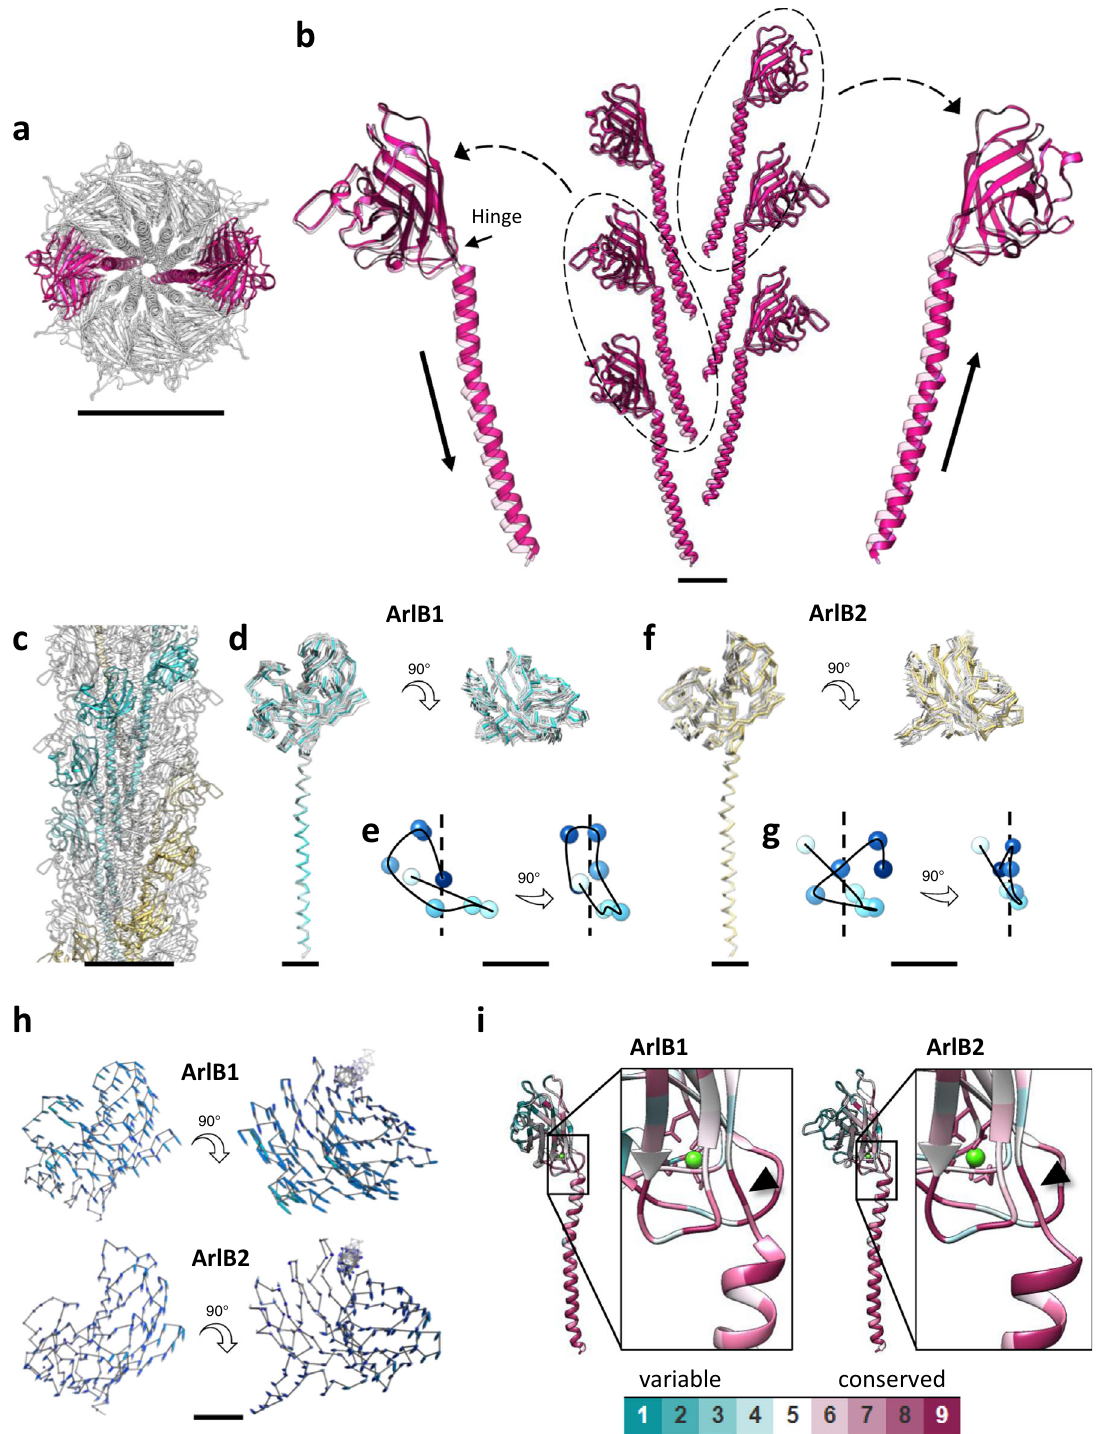
Fig. 5 Flexibility of the M. villosus archaellum. a , b Atomic model showing the motion of the tail domains. Two opposite n + 10 sets of protein monomers ( a ) were selected and the head domains of the constituting monomers were aligned. The solid and transparent magenta models ( b ) were fi tted into the frame 0 and frame 19 maps of the cryoSPARC 3DVA, respectively. The arrows along the tail domains in b highlight the up-down motion of the tail domains of opposite n + 10 strands. c – g Atomic models and motion trajectories showing the fl exibility of the head domains along a full fi lament turn. Eight ArlB1 and eight ArlB2 monomers forming a full helical turn were selected ( c ) and their tail domains aligned. Panels d , f show the fl exibility of the head domains of ArlB1 and ArlB2, respectively. Panels e , g represent the motion trajectories of the centroids (shades of blue) of each head domain. The black curve highlights the trajectory, and the dotted black line represents the fi lament axis. h Atomic models of one ArlB1 and one ArlB2 head domains showing their displacement during fi lament motion. The motion is visualised by vectors linking the backbone atoms of the atomic models fi tting into the frame 0 (grey line) and frame 19 (not shown for better clarity) maps of the cryoSPARC 3DVA. i Estimation of the evolutionary conservation of AlrB1 and ArlB2. Insets focus on the hinge region. Scale bars in a and c , 50 Å; in b , d , f , h , 10 Å; in e and g , 2